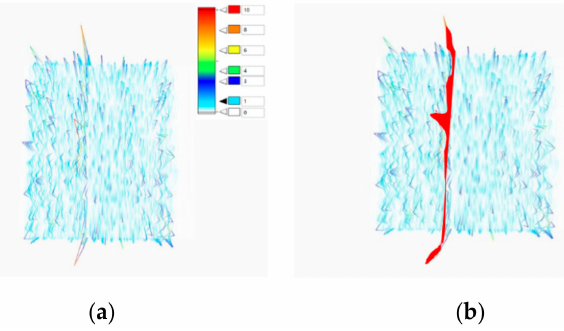
Figure 10. ( a ) Time-frequency spectrum; ( b ) the main energy distribution